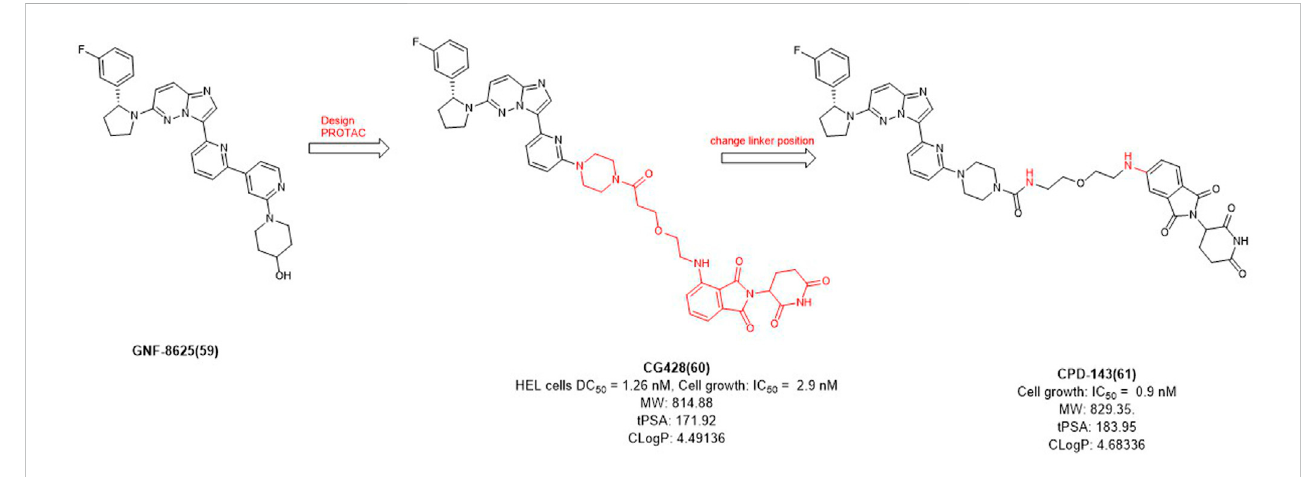
FIGURE 6 Design and optimization of TRK